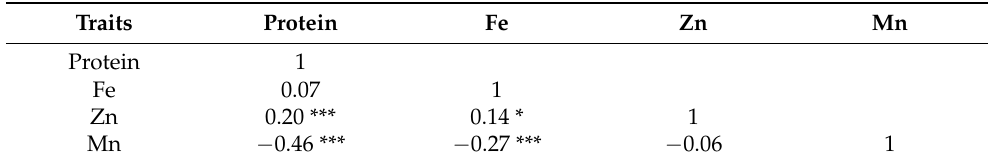
Table 7. Pearson coefficients of phenotypic correlation among nutrient traits: protein content, iron (Fe), zinc (Zn) concentrations, and manganese (Mn)